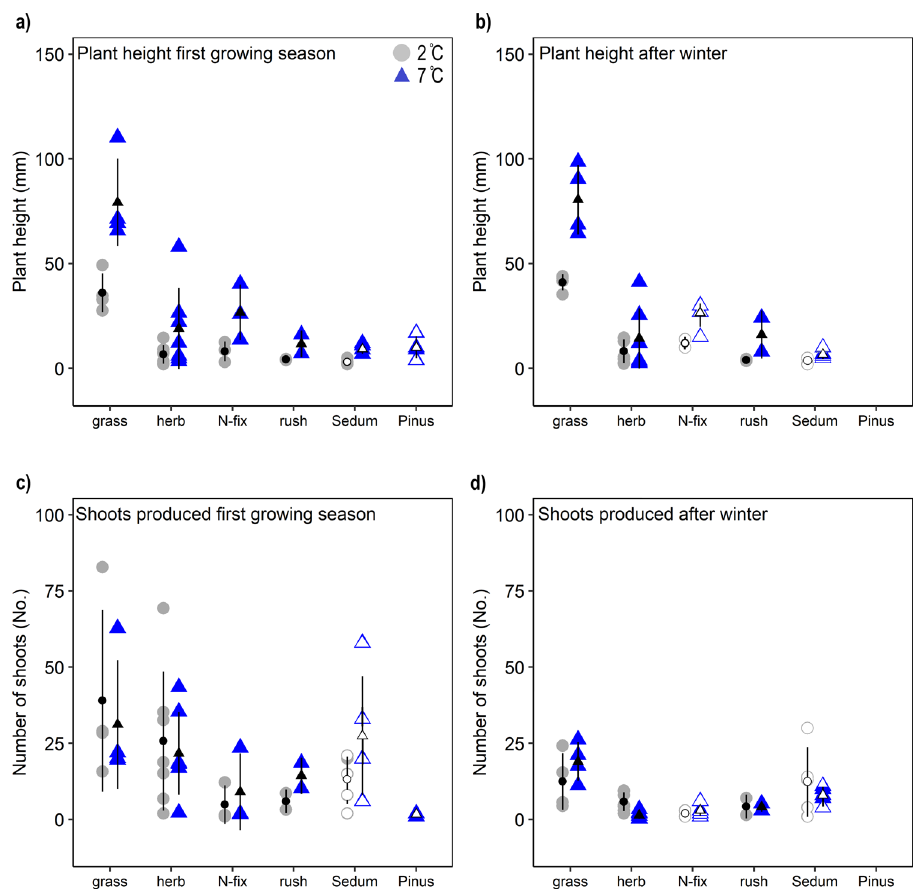
Fig. 2 Plant growth responses to temperature. Plant height and the number of shoots of the main plant types under Antarctic growing season temperatures (2 °C; grey circles) and climate warming (7 °C; blue triangles) in Antarctic soil. a Plant height at the end of the fi rst growing season. b Plant height at the end of the second growing season after the simulated winter period. c Number of plant shoots produced at the end of the fi rst growing season. d Number of plant shoots produced at the end of the second growing season after the simulated winter period. Grey circles and blue triangles represent species-speci fi c means within each plant type (grass: 4, herb: 7, N- fi x: 3 and rushes: 2), with the exception of Sedum album and Pinus sylvestris where ‘ open ’ data points represent experimental pots (n = 4-5) and for N- fi xing plants after winter when only Astragalus cruckshanksii grew (n = 4-5). Black symbols represent the mean with SD as error bars. For a complete species list see Supplementary Tables 1 and